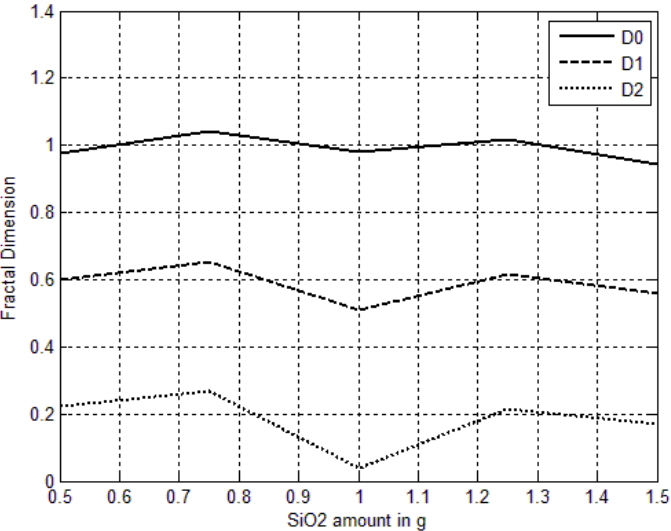
Figure 8. Graphs of generalized fractal dimensions (Algorithm Step 4.2 and Stage 6).